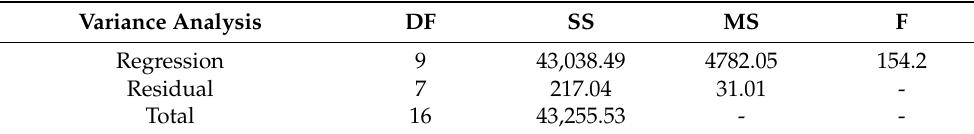
Table 5. Temperature regression model significance